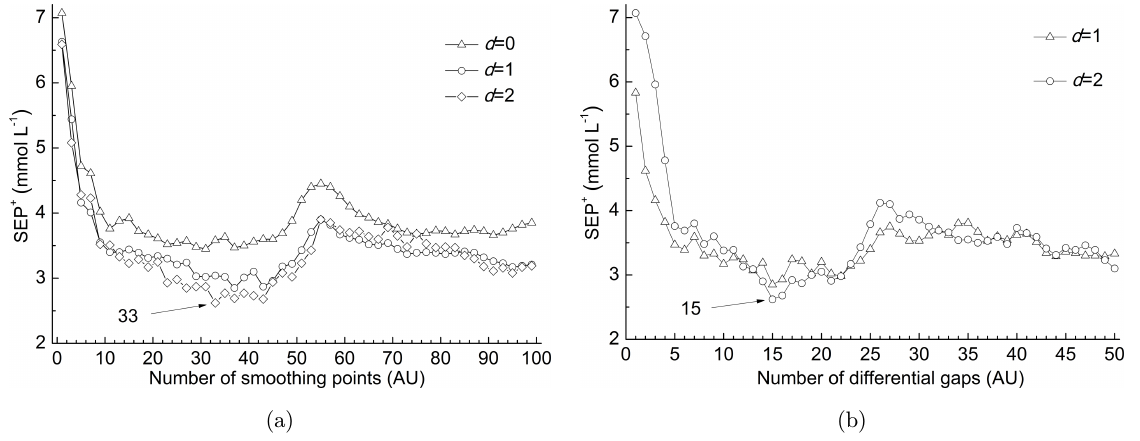
Fig. 2. Optimal SEP þ of Norris-PLS models that correspond to each single parameter: (a) number of smoothing points, and (b) number of di®erential